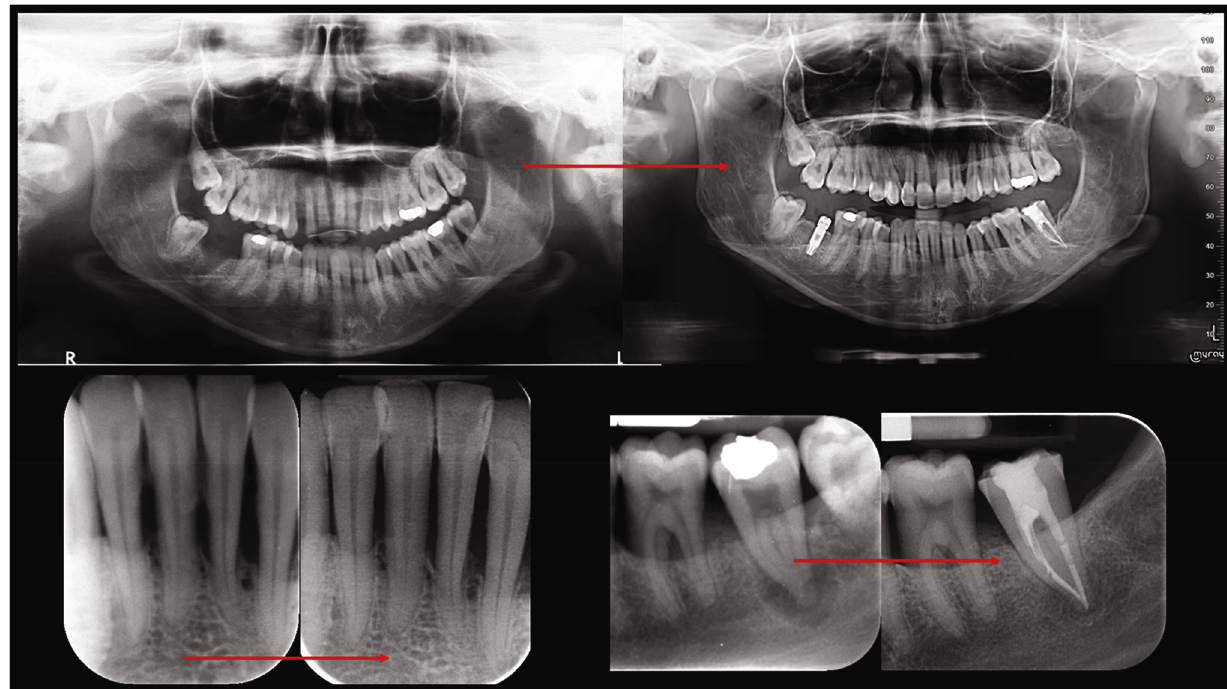
Figure 12: Clinical case: Rx pre- and post-treatment.